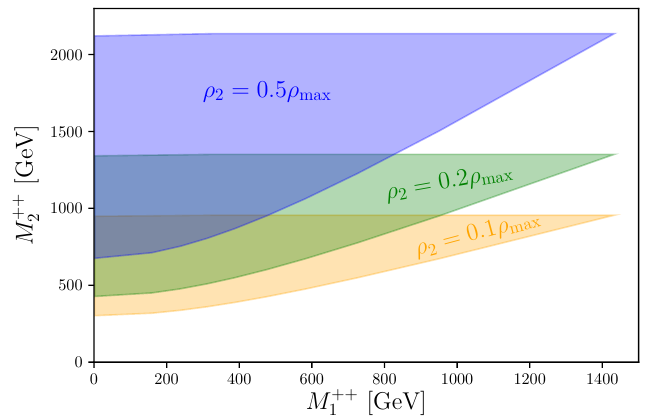
Figure 6 . The global minimum constraint on the two doubly charged scalar masses ( M (cid:6)(cid:6) for the benchmark point given by eq.